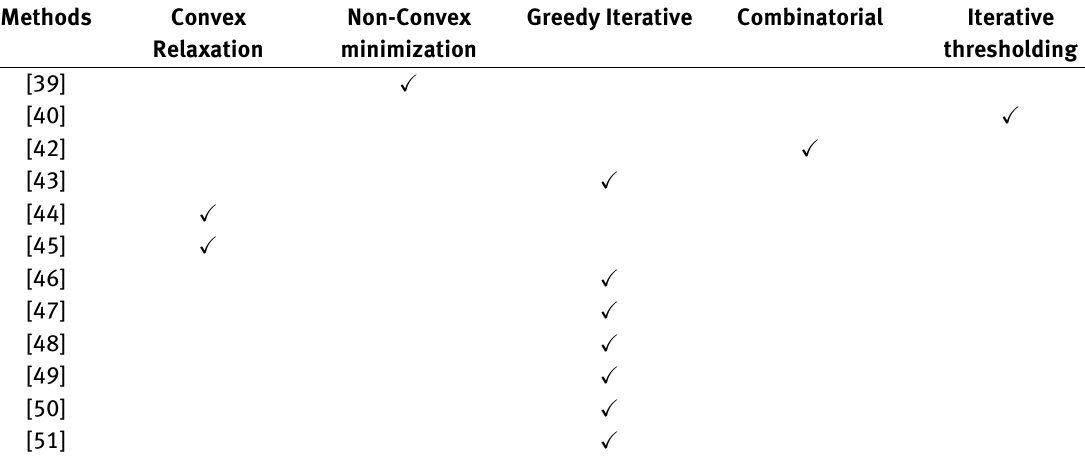
Table 1: Analysis of reconstruction methods in Compressive Sensing Methods